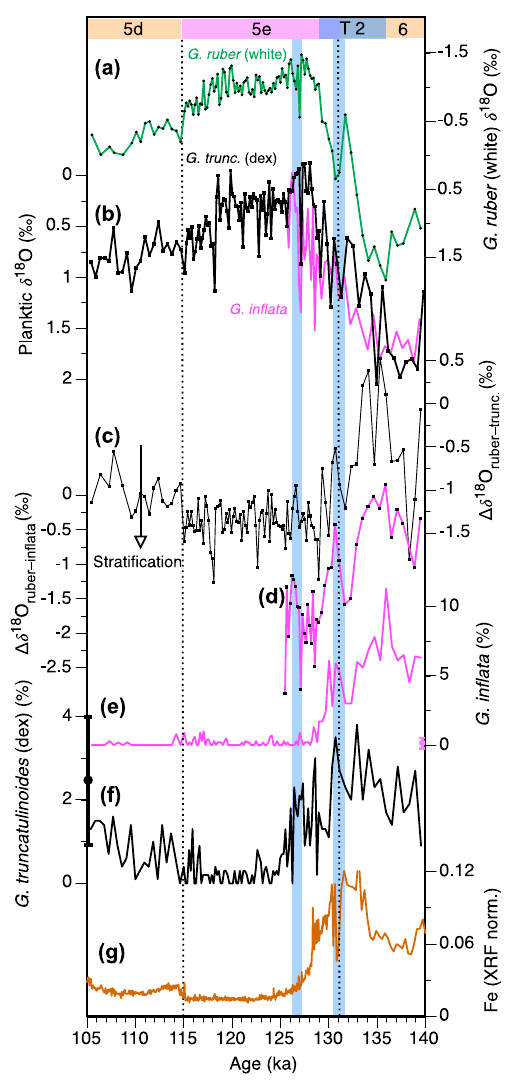
glacial cycle. (a) δ 18 O values in G. ruber (white) (Lantzsch et al., 2007); (b) δ 18 O values in G. truncatulinoides (dex) (in black) and G. inflata (in magenta); (c–d) isotopic gradients between δ 18 O val- ues in G. ruber (white) and G. truncatulinoides (dex) and G. ruber (white) and G. inflata , respectively; (e–f) relative abundances of G. inflata and G. truncatulinoides (dex), respectively; and (g) normal- ized Fe intensities. Also shown in (e) and (f) are the modern rela- tive foraminiferal abundances (average value ± 1 σ ) around Bahama Bank, computed using the seven nearest samples from the Siccha and Ku ˇ cera (2017) database. Vertical blue bars represent periods of decreased water column stratification, discussed in the text. Dashed vertical lines frame MIS 5e. T2 represents Termination